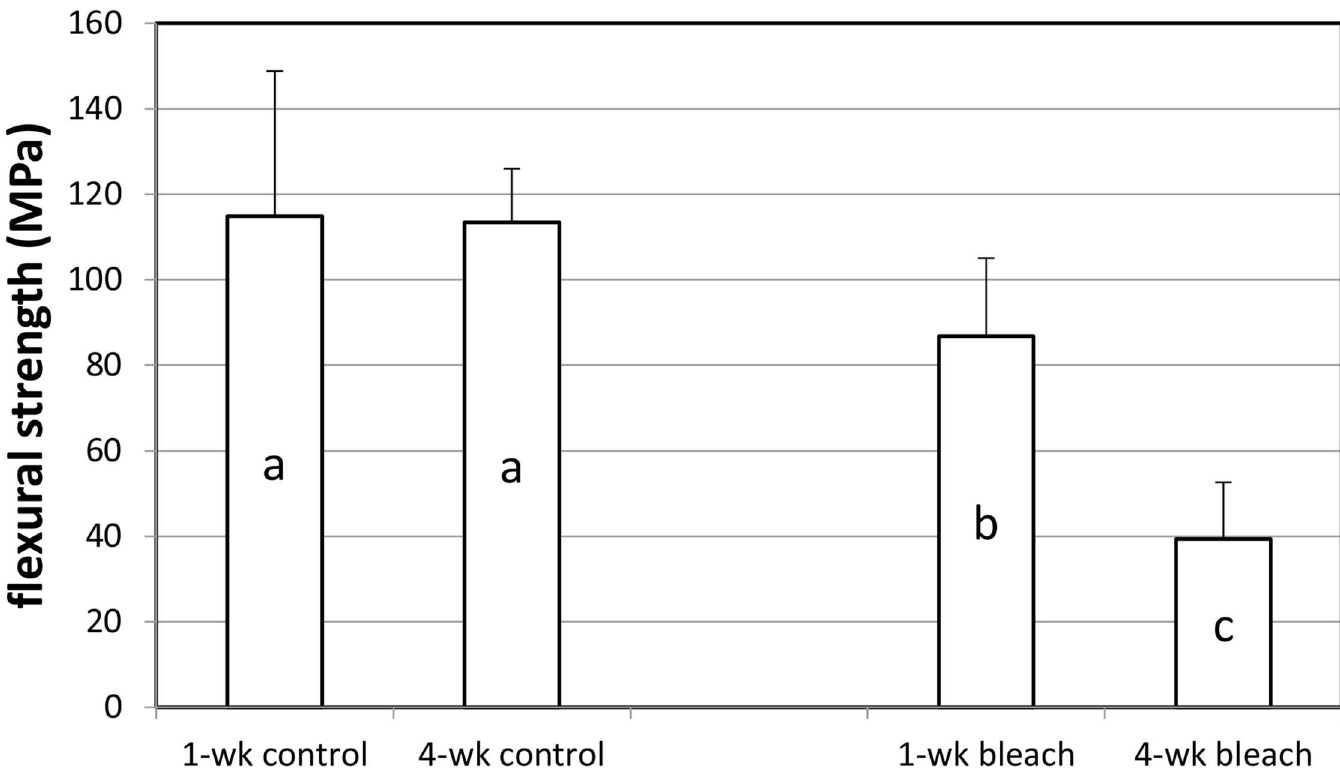
Fig 2. Mean flexural strength results ( ± standard deviation). There were significantdifferencesin mean flexuralstrength amongthe groups (p < 0.001). Groups denotedby the same letter indicates no significantdifference (p < 0.05).